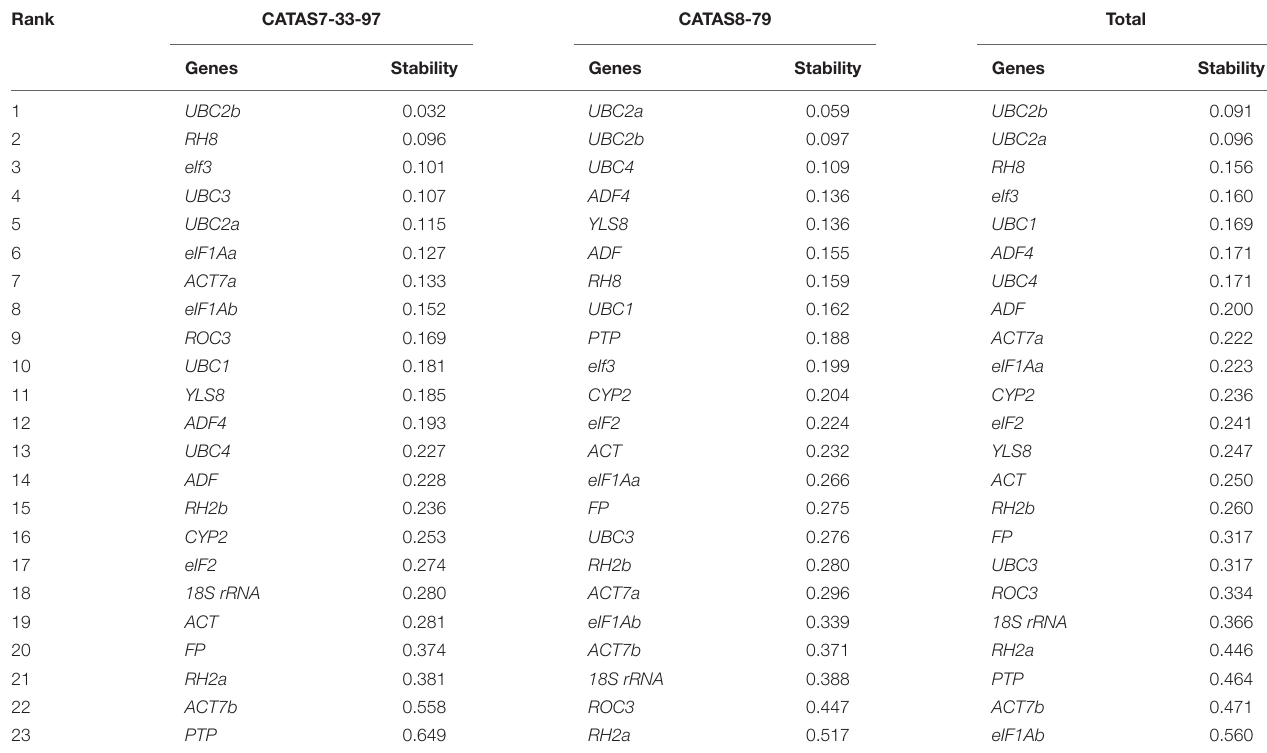
TABLE 1 | Expression stability of 23 candidate reference genes as calculated by